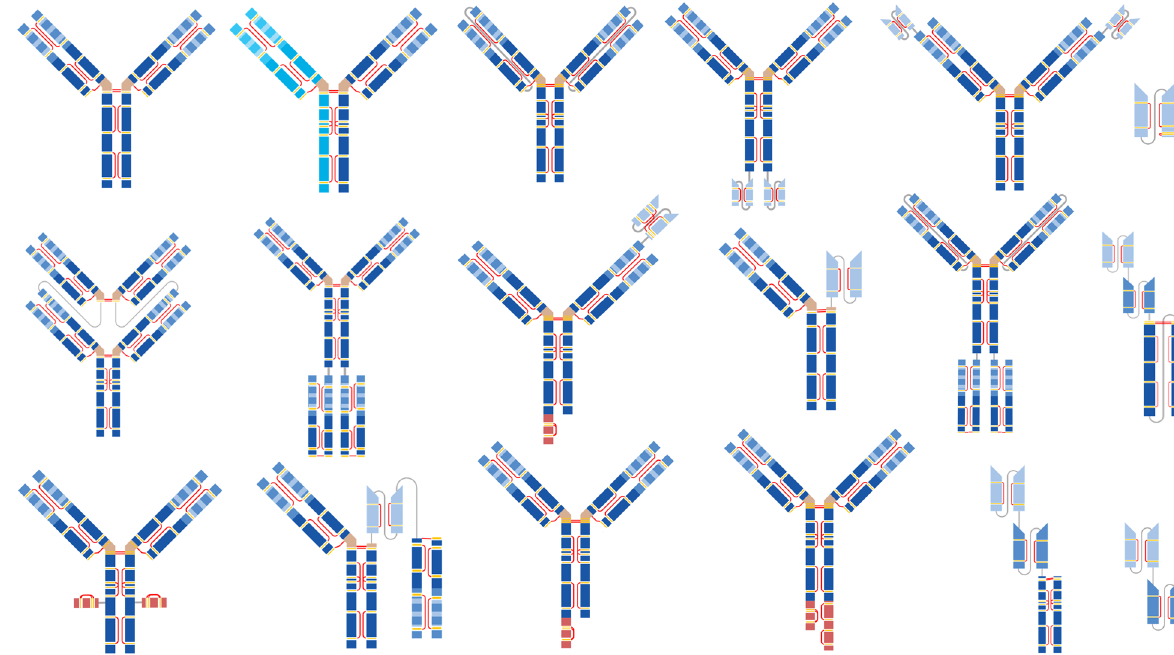
Fig. 7 Gallery of selected BioMaps for a variety of large molecule formats